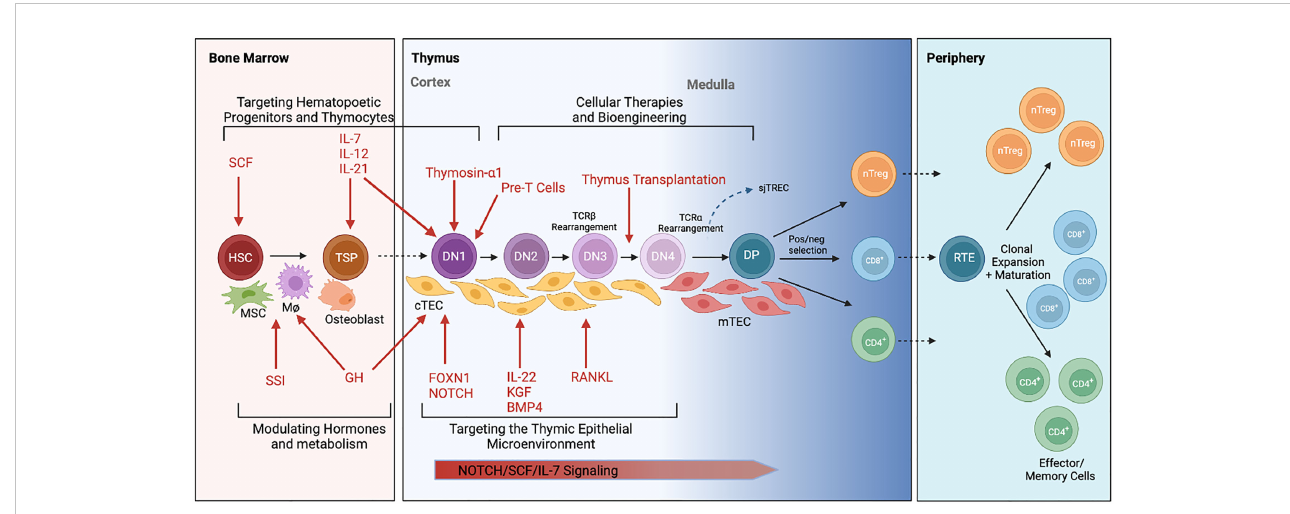
FIGURE 2 Schematic illustration of intrathymic T cell development and current approaches to thymus rejuvenation. T cell development begins with migration of hematopoietic stem cells (HSC) from the bone marrow to the thymus. These thymic seeding progenitors (TSPs) undergo lineage commitment as they transform from double negative (DN) to double positive (DP) to single positive T cells with the assistance from critical signals within the thymic epithelial microenvironment. T cells are eventually exported out of the thymus as CD4+, CD8+ or regulatory T cells (Tregs) where they function within the periphery. Various therapeutic approaches (in red) to rejuvenating thymic function are currently under investigation. This includes approaches to 1) target hematopoietic progenitors and thymocytes, 2) target the thymic epithelial microenvironment, 3) modulate hormones and metabolism, and 4) develop cellular therapies to replace thymic tissue. Elements of this fi gure were generated using